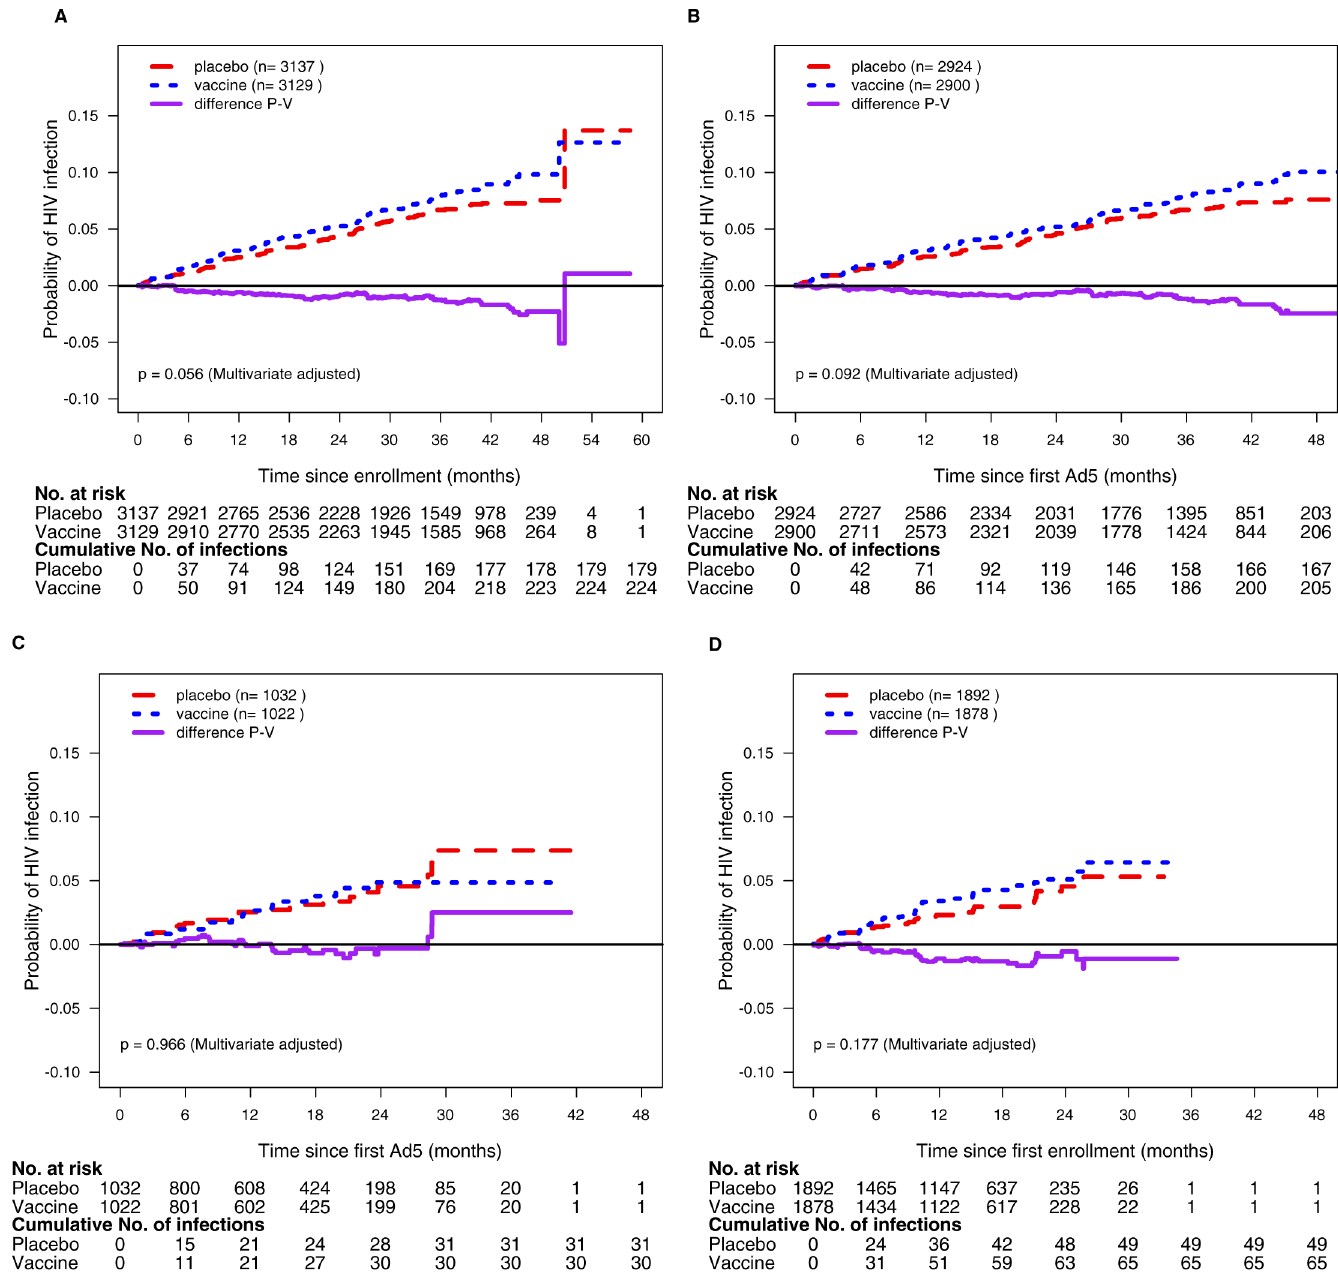
Fig 3. Kaplan-Meier Curves and Their Difference (Vaccine vs Placebo) of Cumulative Incidence of HIV-1 Infection. These incidence estimates were not adjusted for covariates. Panel A is for the MITT cohort and Panel B is for the Ad5 cohort based on Step, Phambili and HVTN505 combined using all follow-up time; Panel C is for the Ad5 Cohort based on HVTN505 alone using follow-up time before unblinding, and Panel D is based on Step and Phambili combined using follow-up time before unblinding. The MITT cohort included all randomly assigned participants HIV-1 uninfected at study entry, who received at least one dose of vaccine or placebo; the Ad5 cohort included MITT participants who received at least one dose of rAd5-HIV vaccine or